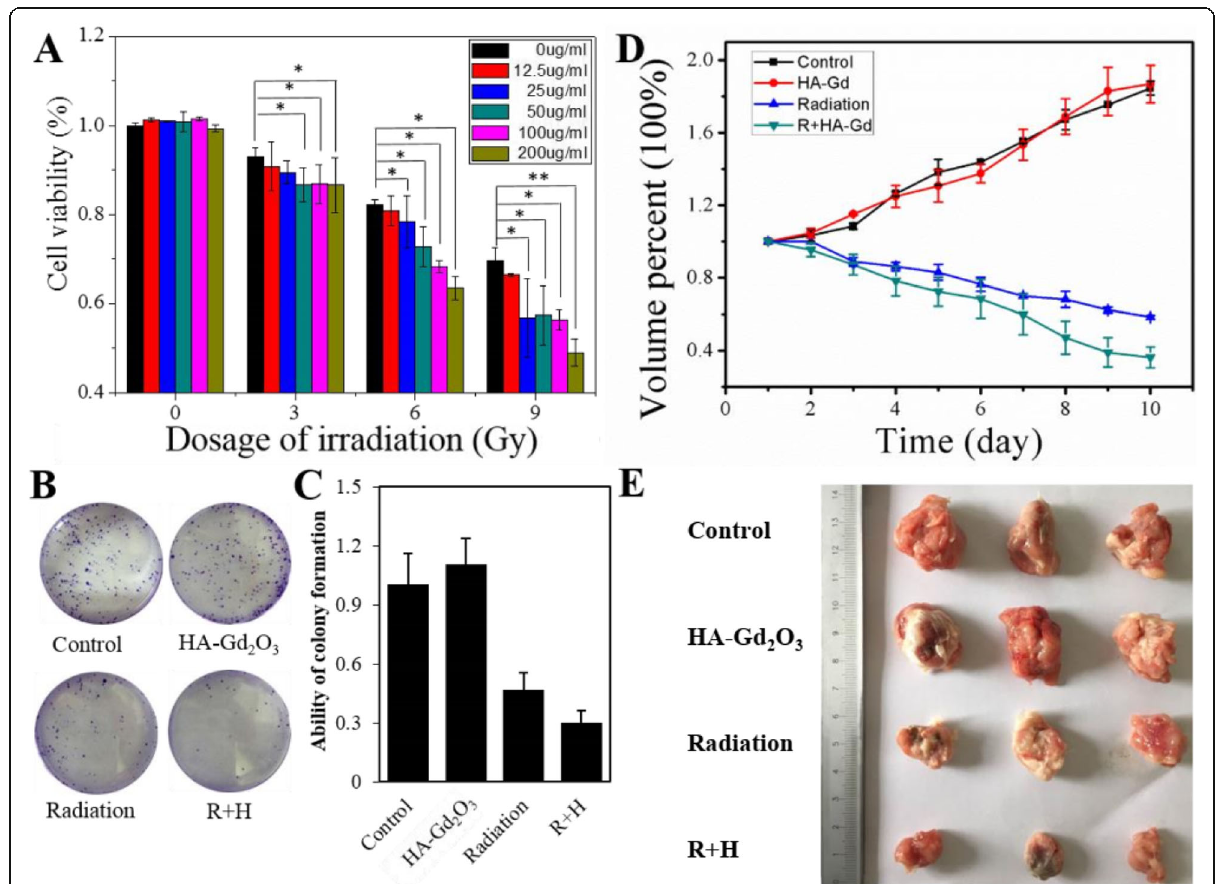
Fig. 6 The radiosensitization effect of HA-Gd 2 O 3 NPs in vitro. a The synergistic effect of HA-Gd 2 O 3 NPs (0 μ g/mL, 12.5 μ g/mL, 25 μ g/mL, 50 μ g/mL, 100 μ g/mL, and 200 μ g/mL) and X-ray radiation (0 Gy, 3 Gy, 6 Gy, and 9 Gy) on the viability of HepG2 cells using the CCK-8 assay. * p < 0.05, ** p < 0.01, the difference was statistically significant. b The colonies survival assays of HepG2 cells treated with HA-Gd 2 O 3 NPs and X-ray radiation and c the corresponding quantitative analysis of clonegenesis abilities. d Tumor volume growth curves of different groups of mice after different treatments. Groups: a control, b radiation, c HA-Gd 2 O 3 NPs, and d radiation + HA-Gd 2 O 3 NPs. e Photos of tumors collected from different groups of mice at the end of